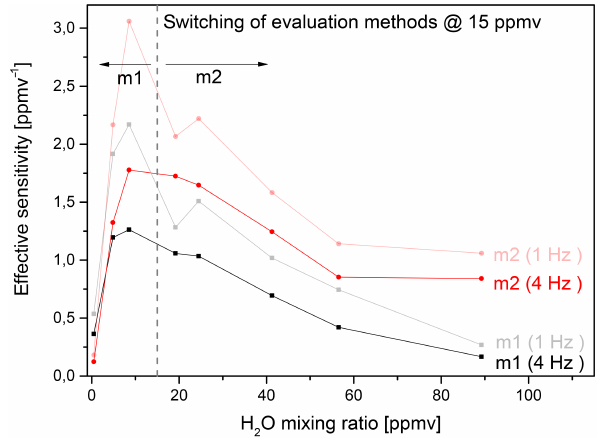
Figure 8. Effective sensitivity, as defined in Eq. (4), for evaluation method 1 (black) and method 2 (red). ES increases up to ∼ 10ppmv due to the increase in the slope of the calibration curve. At higher mixing ratios, the decrease of ES is caused by increasing signal noise. Below 15ppmv, method 1 is used for calculation of atmo- spheric mixing ratios; above 15ppmv, method 2 is